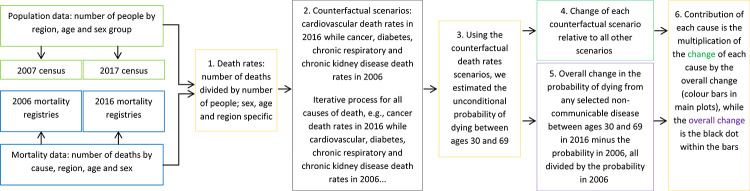
Summary of methods.